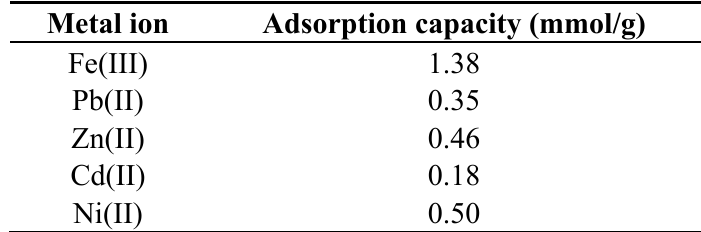
Table 3. Adsorption capacity for Fe(III), Pb(II), Zn(II), Cd(II),